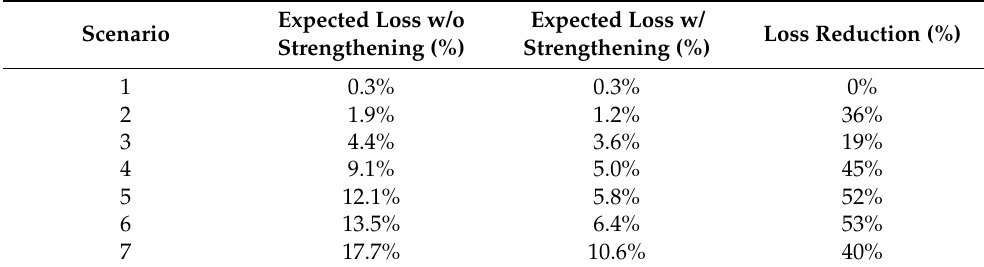
Table 8. Expected losses and loss reduction with and without a test strengthening intervention in four schools for the considered seismic